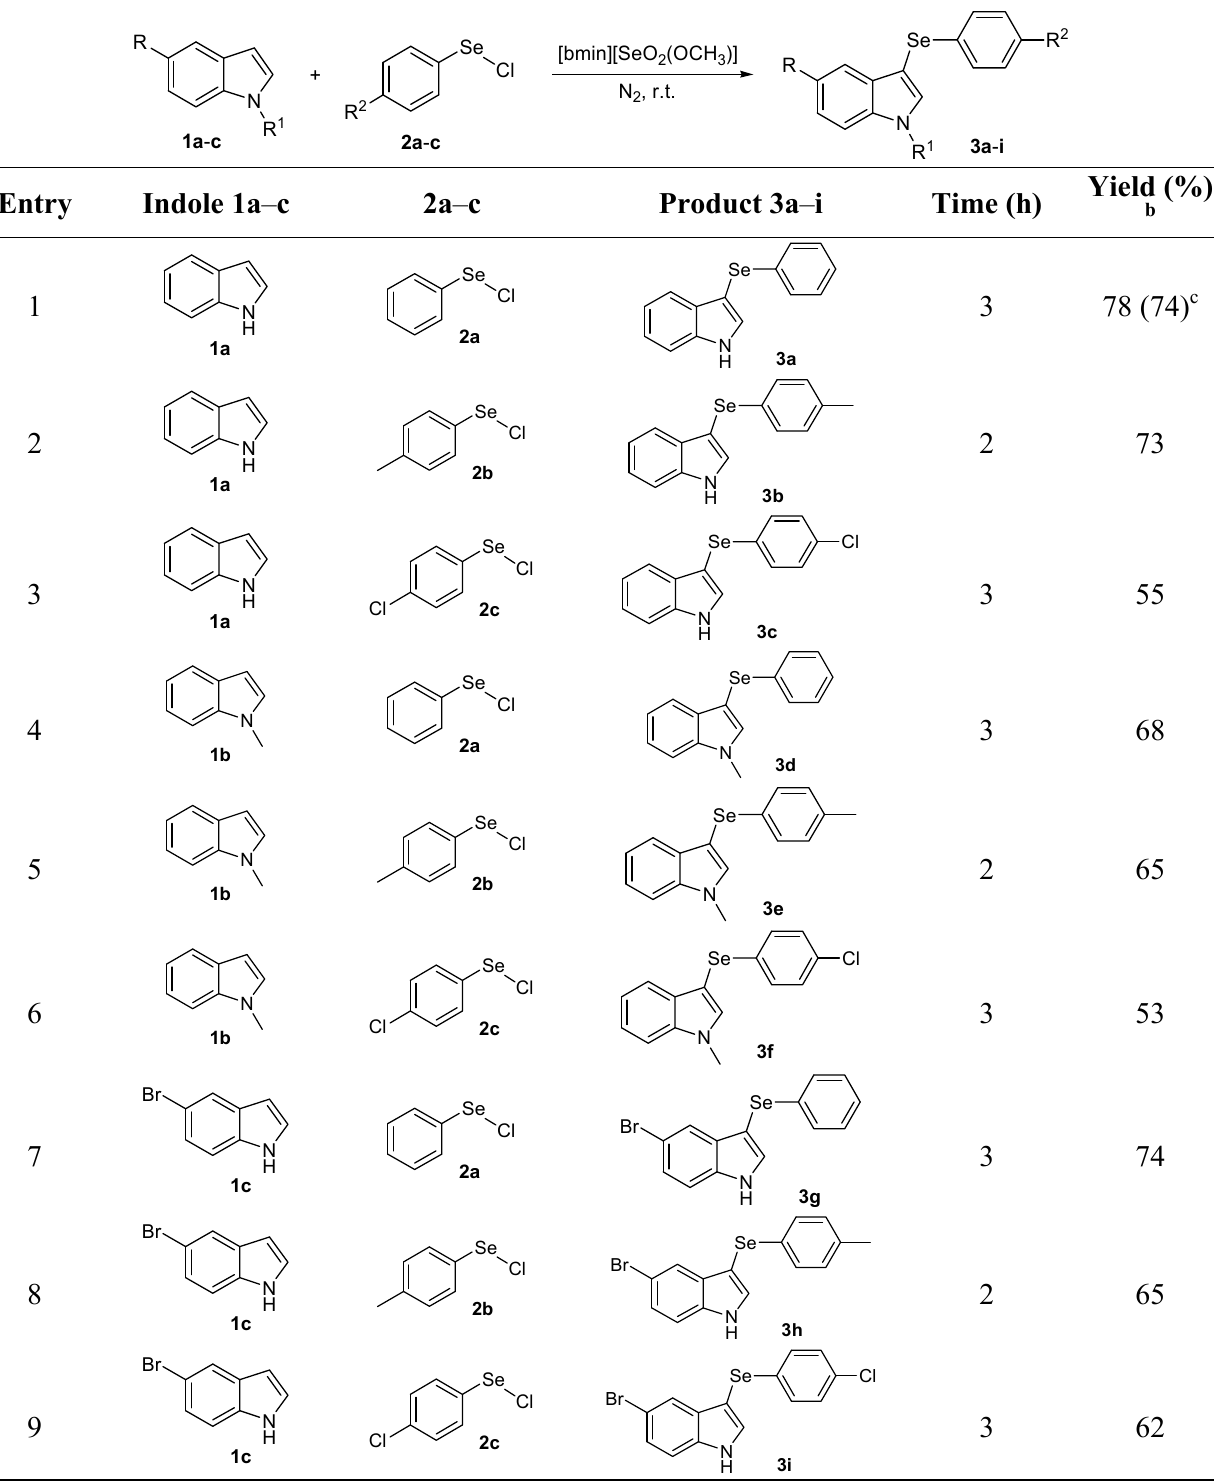
Table 2. Synthesis of 3-organylselanylindoles a